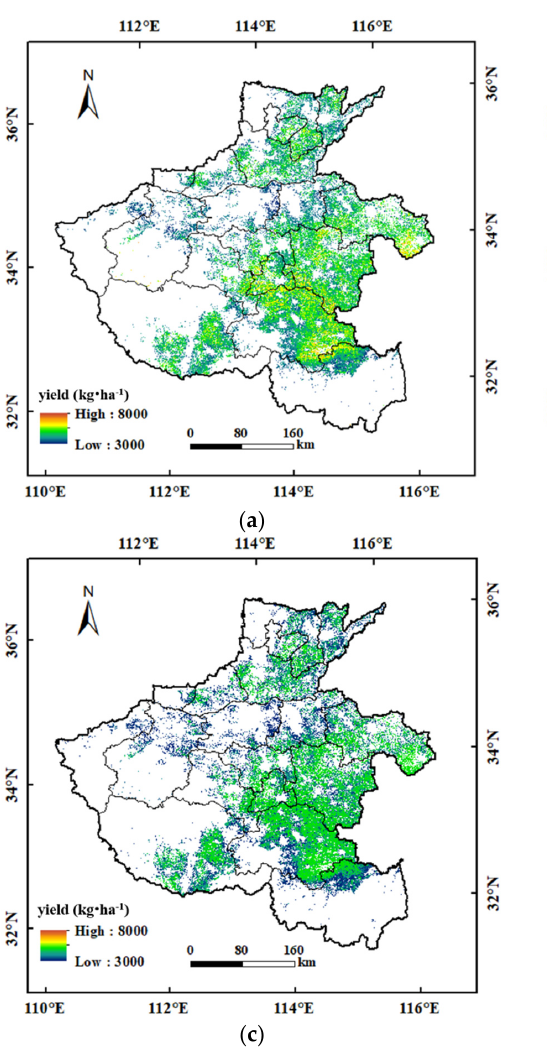
Figure 10. Regional wheat yields in Henan Province in 2018, which were obtained with the LSTM (a), 1-D CNN (b) and RF (c) models.